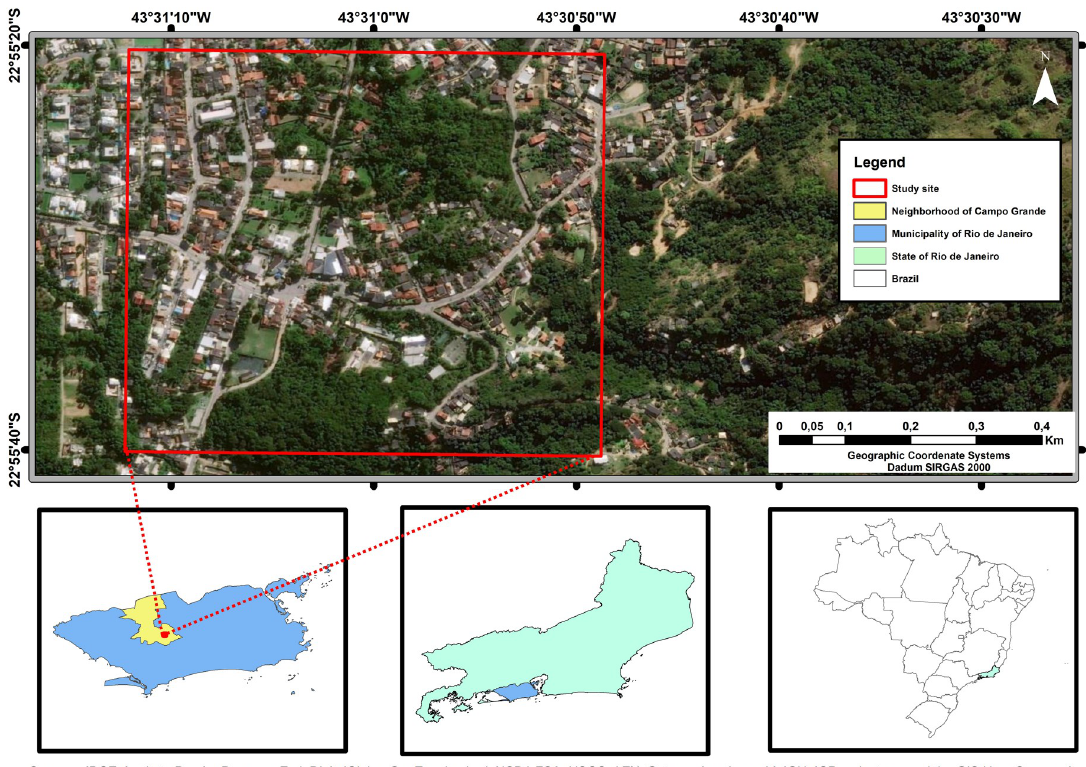
Fig 1. Geographical location of the study region where fecal samples from dogs and cats were collected.